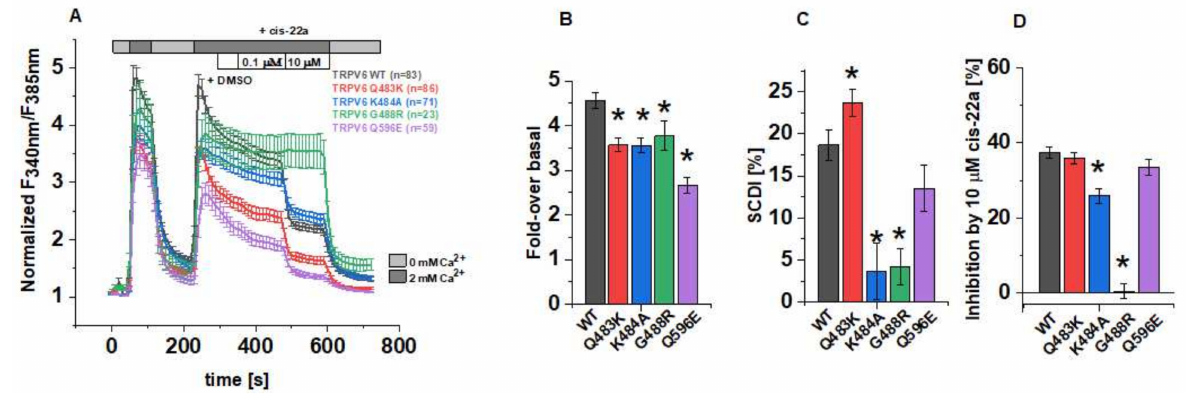
Figure 1. Functional characterization of TRPV6 mutants in Fura-2 experiments. ( A ) Changes in the intracellular Ca 2+ level of HEK293 cells overexpressing human TRPV6 WT or the respective mutant upon perfusion with Ca 2+ -free extracellular solution (ECS), 2 mM Ca 2+ -containing ECS, 0.1 vol% DMSO, 0.1 µ M and 10 µ M cis-22a in 2 mM Ca 2+ -containing ECS, as indicated by the bars. Fura-2 emission was monitored in intervals of 10 s upon alternating excitation at 340 nm and 385 nm. After background subtraction, the ratio of the respective emission intensities was determined (F 340nm /F 385nm ) and normalized to the minimum F 340nm /F 385nm for each cell. Shown are averaged time courses (mean ± SEM) of 23–86 cells, measured on 2-4 days. ( B ) Block diagram summarizing fold-changes in the intracellular Ca 2+ levels at the time point t=250 s according to measurements in ( A ). ( C ) Block diagram of the decrease in intracellular Ca 2+ from t = 250 s to t = 350 s of the measurements in ( A ), serving as indicator for the slow Ca 2+ -dependent inactivation. ( D ) Block diagram of the inhibition by 10 µ M cis-22a in % according to measurements in ( A ). The asterisk (*) indicates the statistical significance ( p < 0.05) in comparison to TRPV6